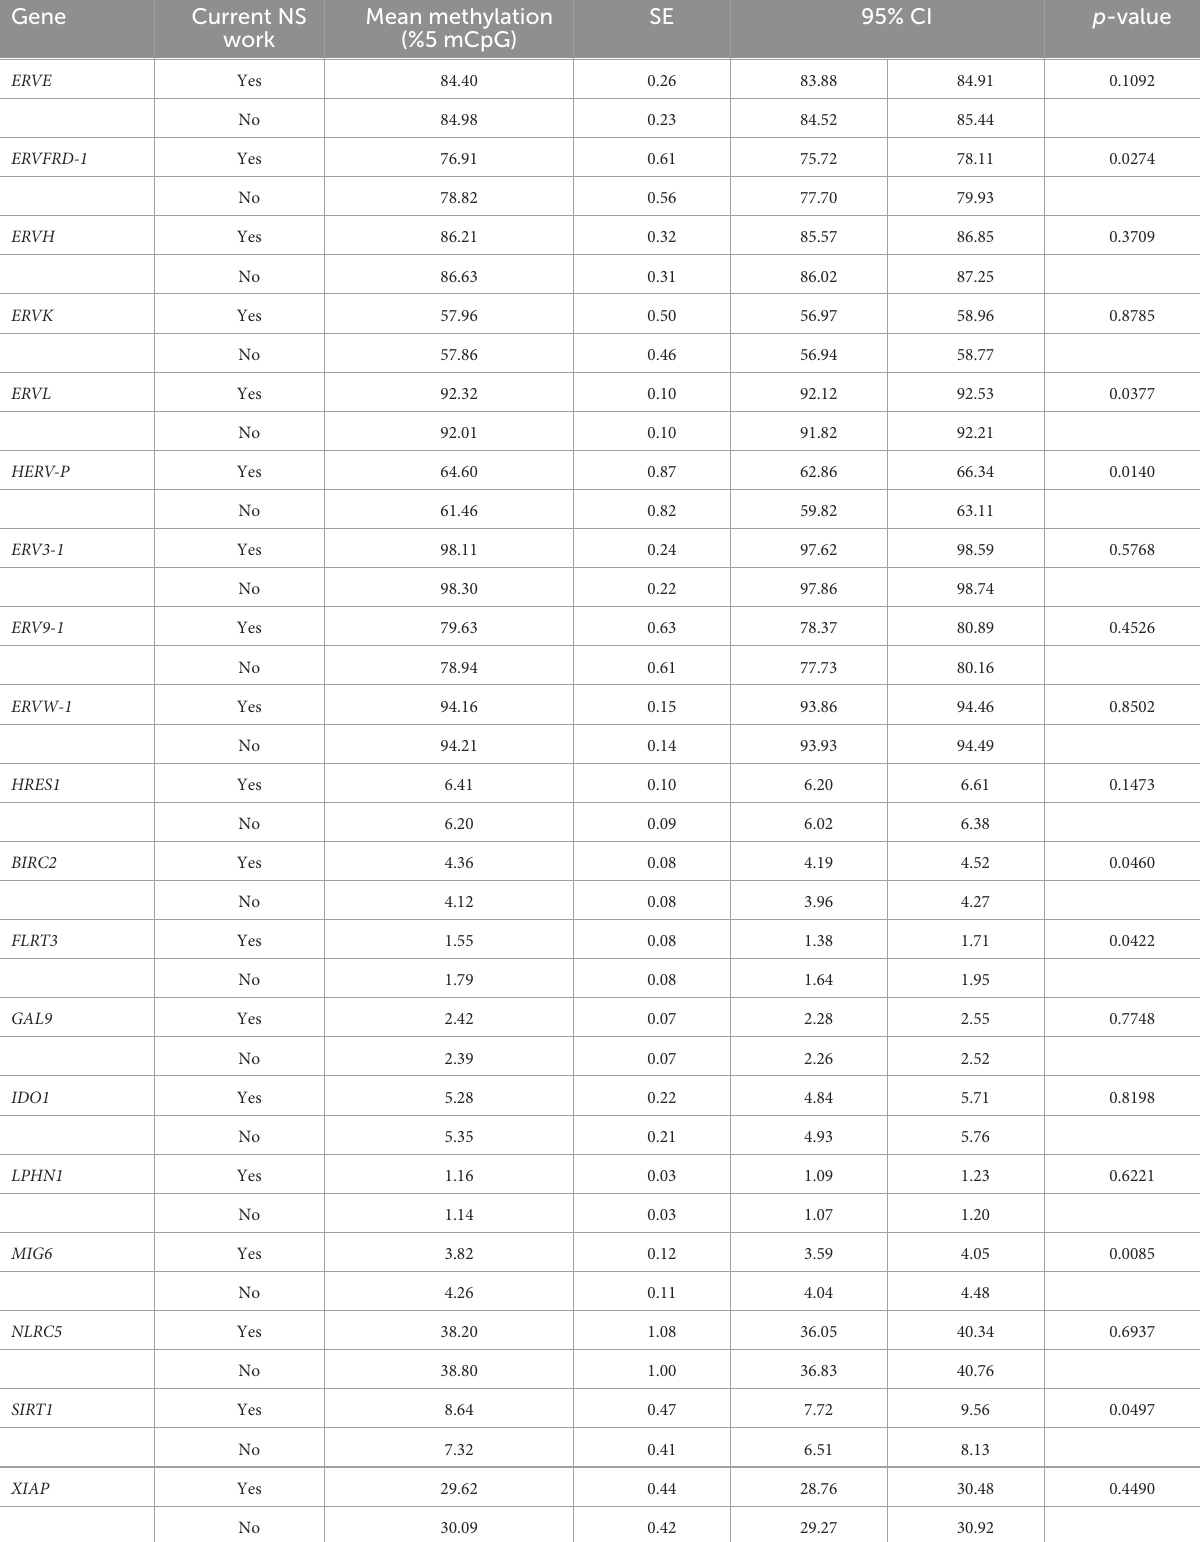
TABLE 3 Association between current NS work and gene-specific methylation.